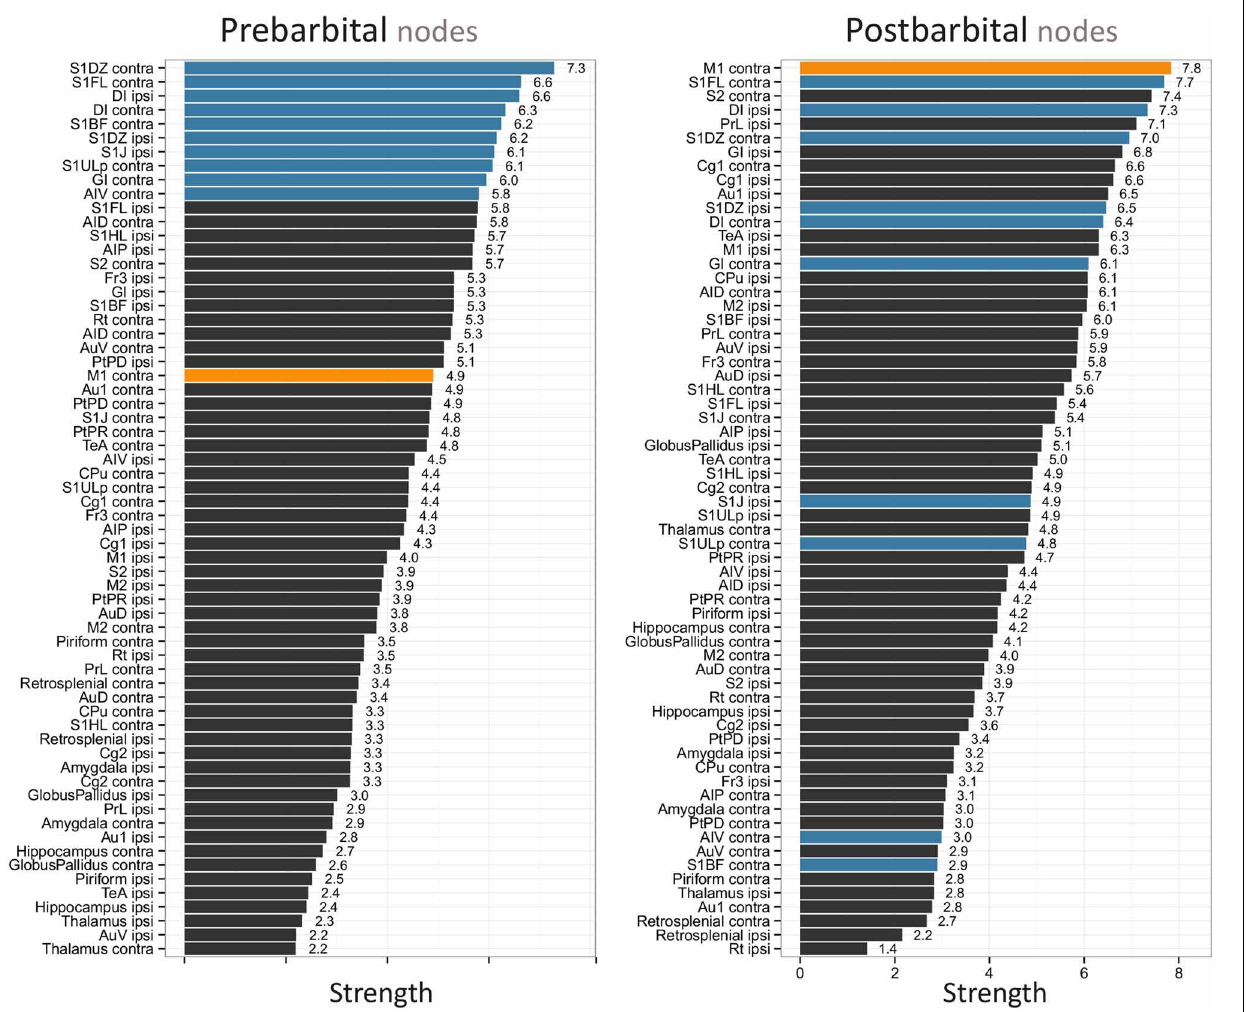
FIGURE 2 | Pre- and postbarbital individual network node strengths plotted as bar graphs. The 64 bilateral nodes are sorted from high to low strength. The 10 network nodes with the highest strength prior to pentobarbital injection are given in blue. The node with the highest strength in the postbarbital functional network, the contralateral primary motor cortex, is given in orange. The following abbreviations are used, contra, left hemisphere, contralateral to cannulation, ipsi, right hemisphere, ipsilateral to cannulation; AID, agranular insular cortex dorsal part; AIP, agranular insular cortex posterior part; Au1, primary auditory cortex; AuD, secondary auditory cortex dorsal area; AuV, secondary auditory cortex ventral area; AIV, agranular insular cortex ventral part; Cg1,